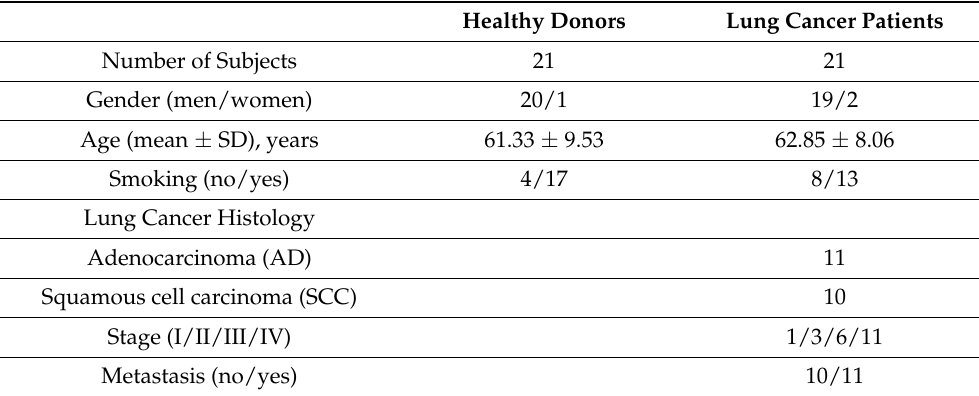
Table 1. Clinical characteristics of lung cancer patients and healthy